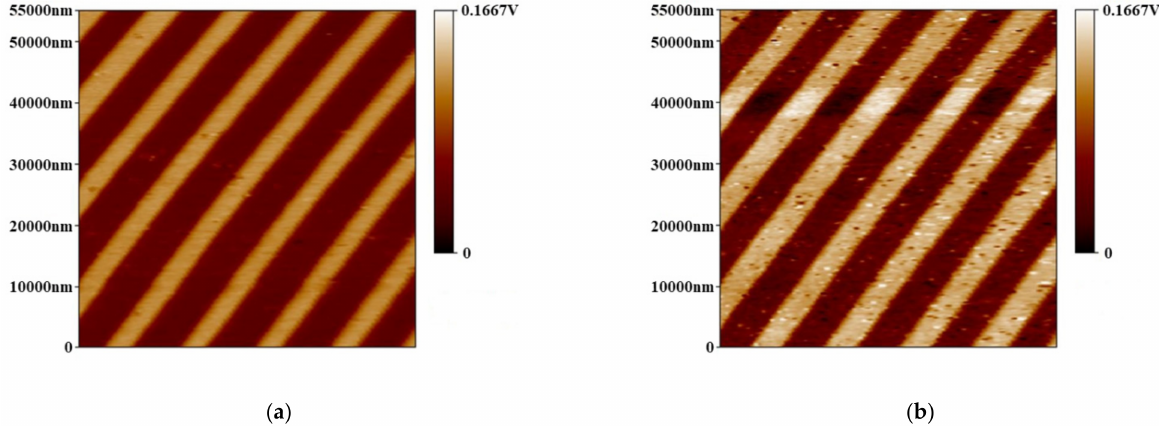
Figure 10. Comparison of the scanning results for the LiNbO 3 single-crystalline samples: ( a ) the first time and ( b ) the 1000th